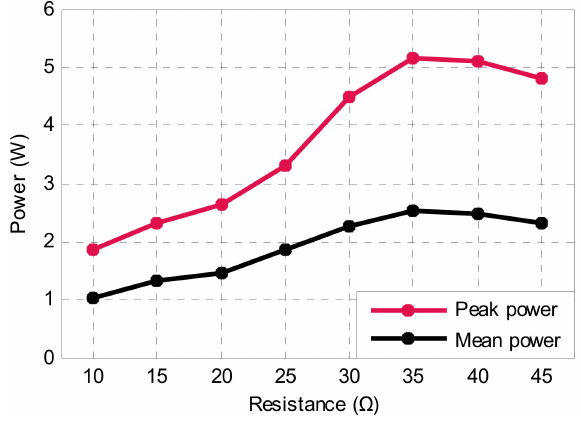
Figure 24. E ff ect of resistance on WEC power